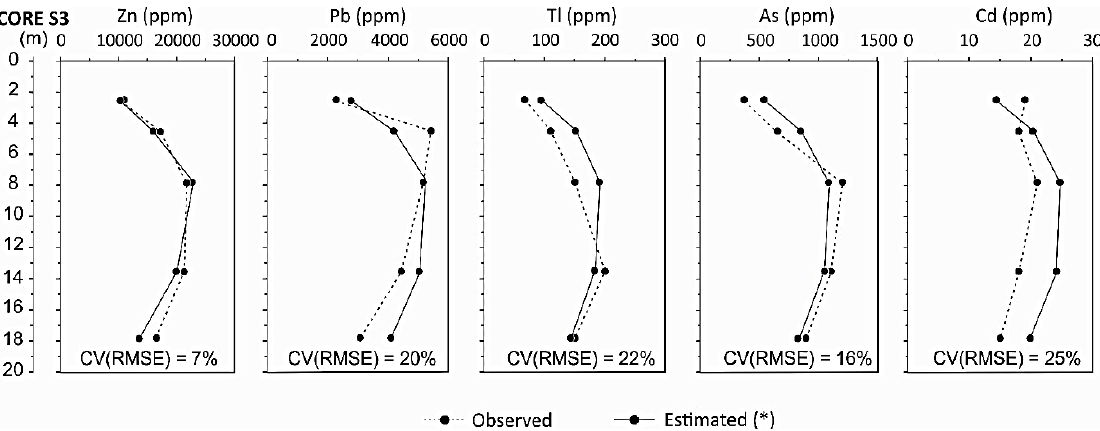
Figure 9. Estimated concentrations of the main metals. Zn* concentrations result from the inverted resistivity values of the ERT geophysical survey, Pb*, Tl*, As*, and Cd* concentrations result from the calculated Zn* concentrations.